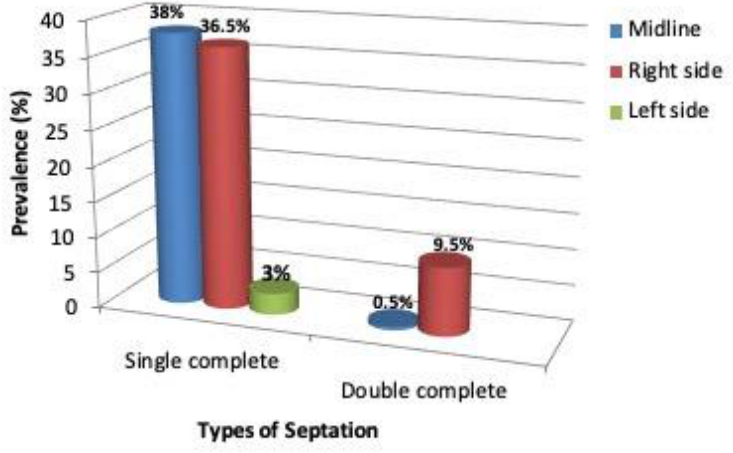
Figure 5. Sphenoid sinus septum in midline, right and left side orientation. Table 3. Summary of relationship of internal carotid artery, optic nerve and foramen rotundum to the sphenoid